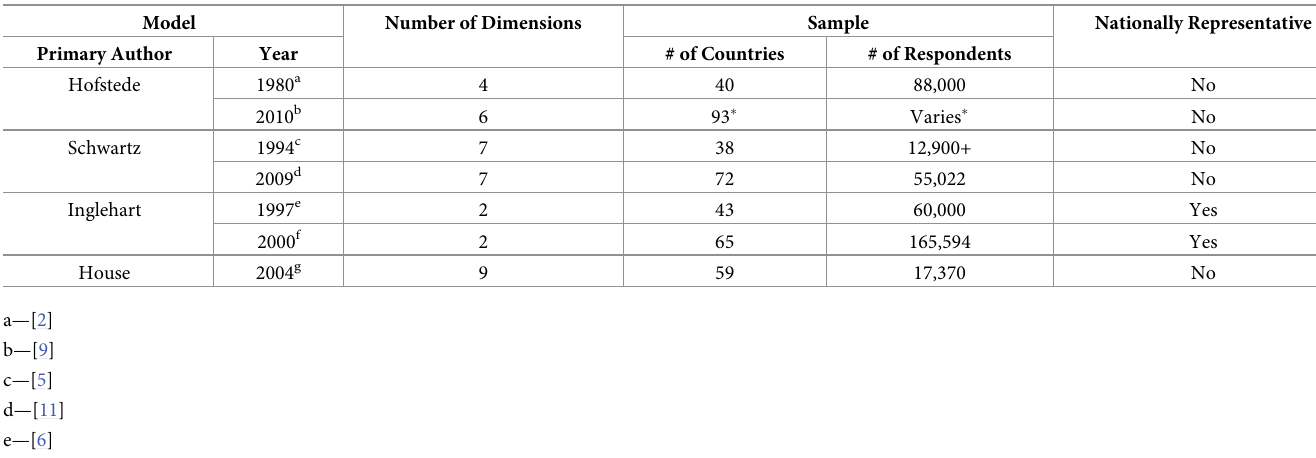
Table 1. Existing cultural